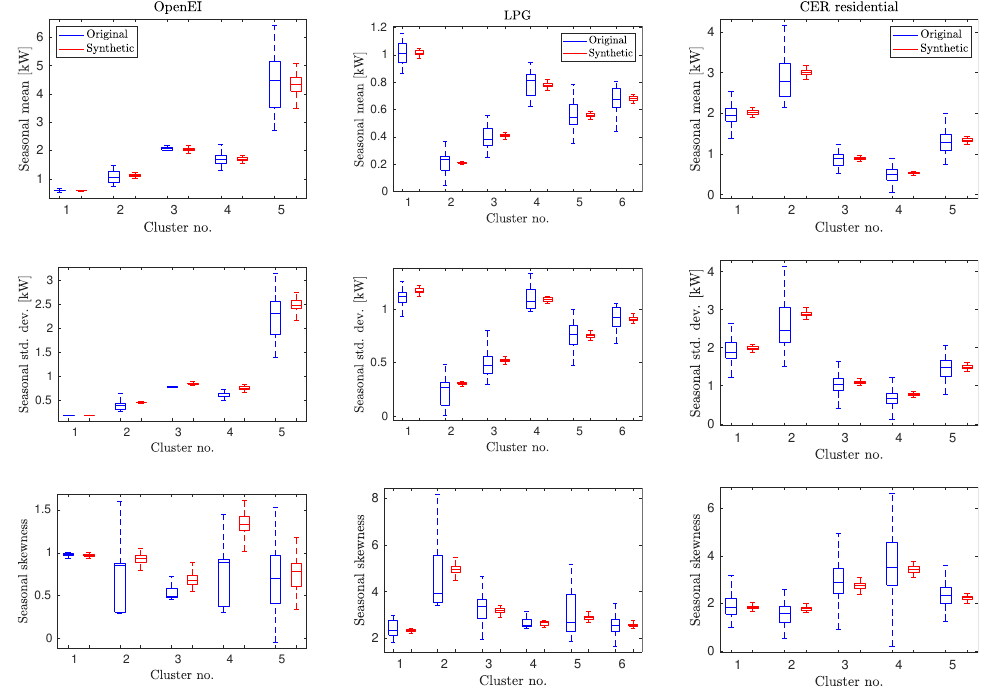
Figure 8. Box-and-whiskers plots of the mean, standard deviation and skewness values of the PDFs of the original LPs (in blue) and the corresponding SLPs (in red), respectively, within the population of each cluster over the whole winter season. The columns of the matrix of plots refer to the three explored data sets, while the rows refer to the analyzed statistical